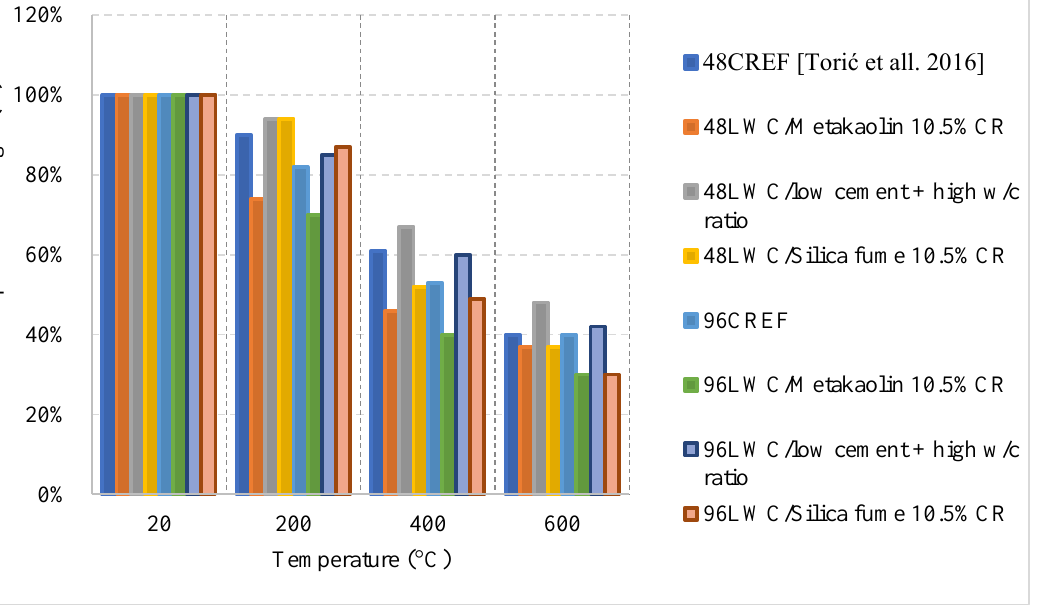
Figure 9. Relative compressive strength of LWC cooled at 1°C/min. 48LWC: Specimens that are tested after 48 h of cooling, 96LWC: Specimens that are tested after 96 h of cooling, CR: Cement replacement [63].